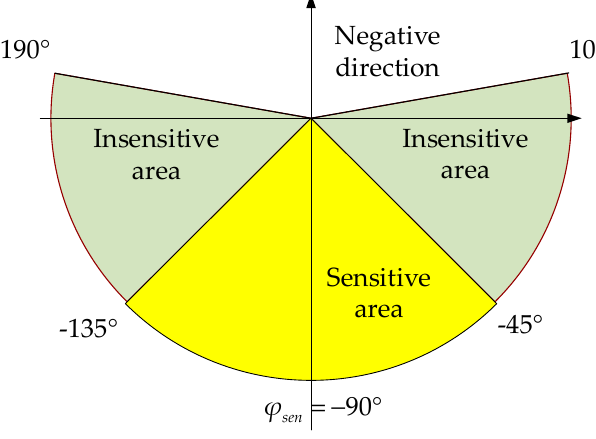
Figure 4. The sensitive area and the insensitive area.